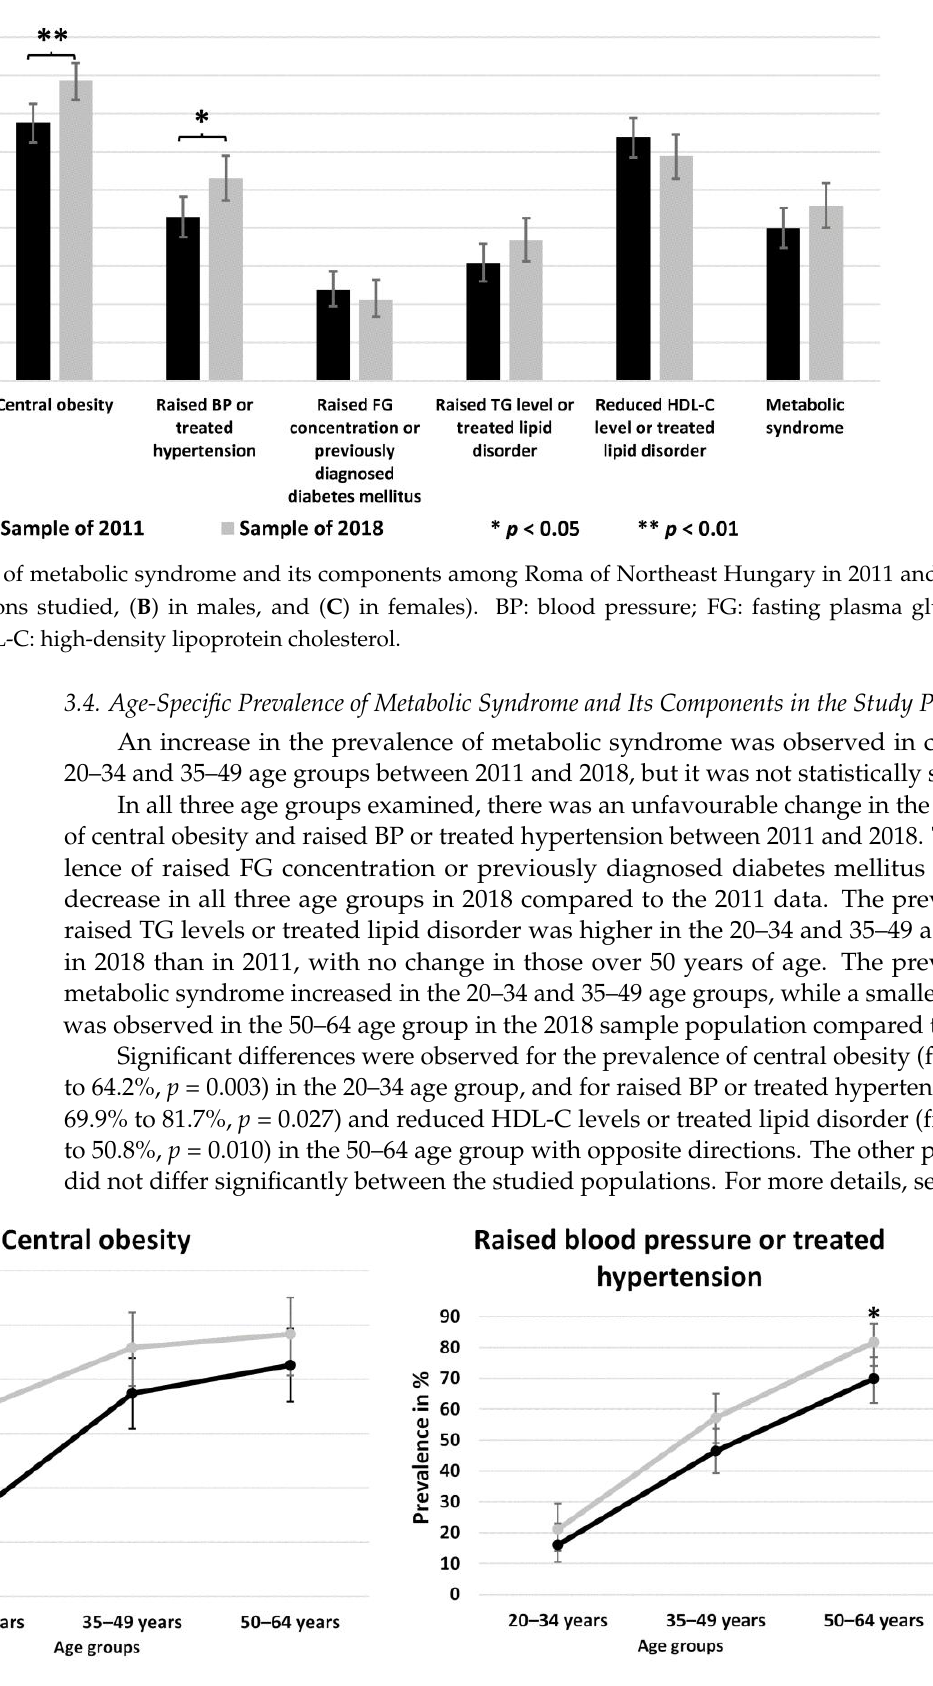
Figure 2. Changes in the prevalence of metabolic syndrome and its components by age group in the Northeast Hungarian Roma population from 2011 to 2018.